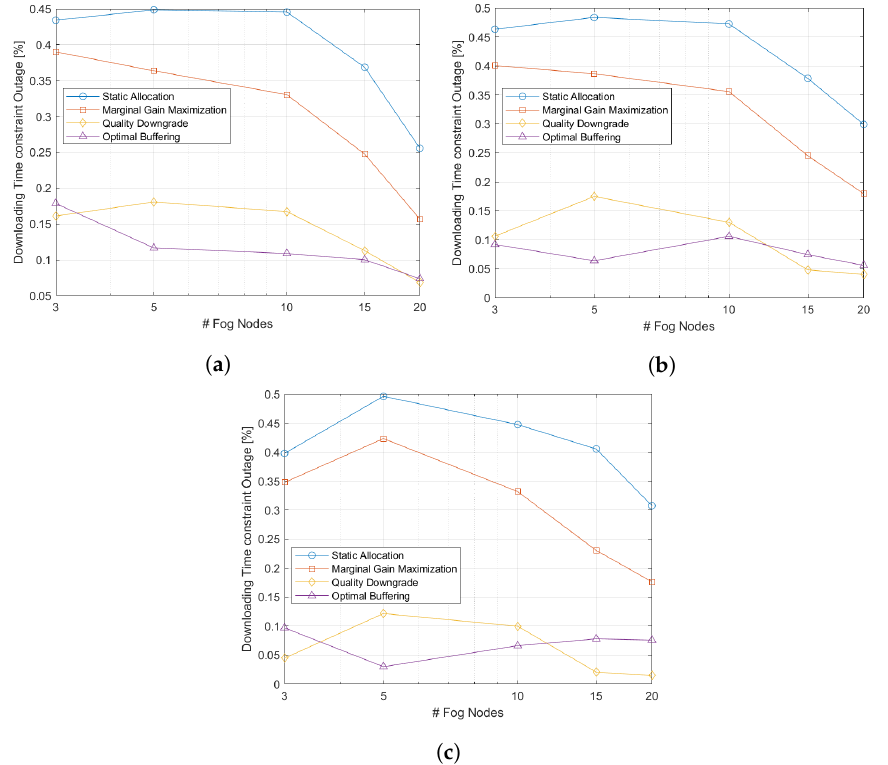
Figure 6. Outage probability with respect to downloading time constraint with variable number of nodes. ( a ) Short videos. ( b ) Medium videos. ( c ) Long videos.